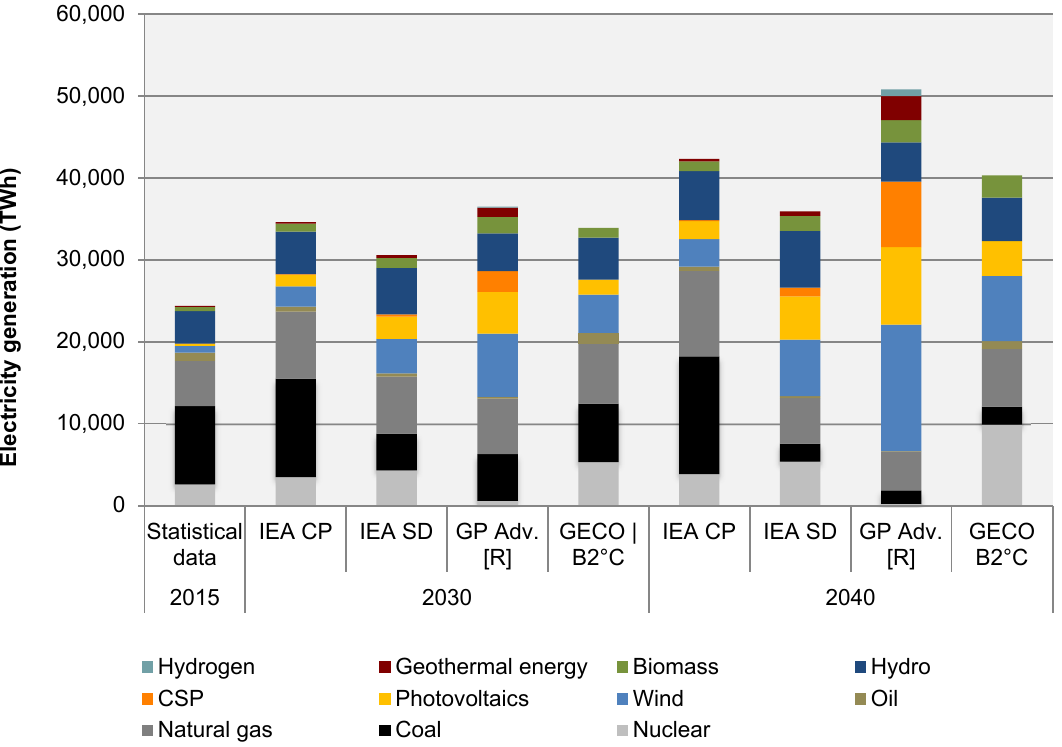
Figure 2. Electricity generation by energy source (in TWh) for the year 2015 and the four selected energy scenarios in 2030 and 2040. (Source: based on the data from [39–41]).